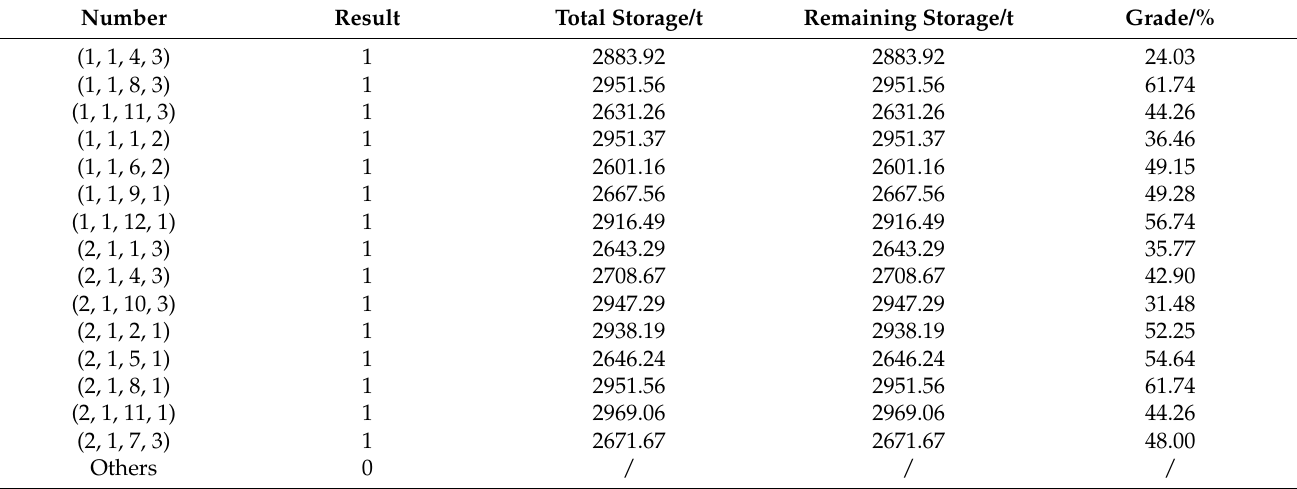
Table 1. Calculation